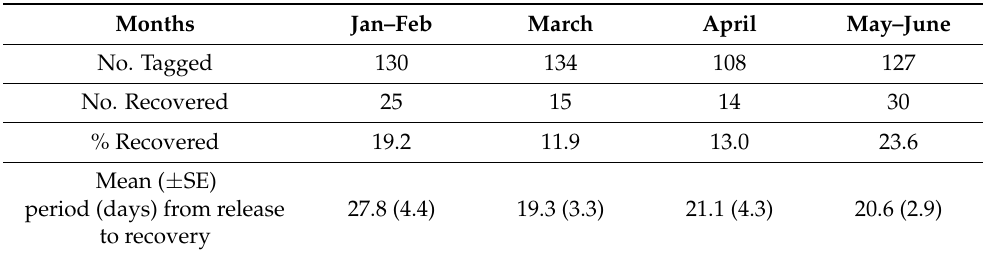
Table 3. Tag and recovery data for monarchs tagged in Santa Clara County during January–June 2021. Statistical analysis shows that differences in recovery rates between months were minor. (Chi-square test, 2 × 4 contingency table, Chi-square = 2.70, df = 3, p = 0.439). Release-recovery periods (days) of tagged monarchs was not significantly different between months ( p >